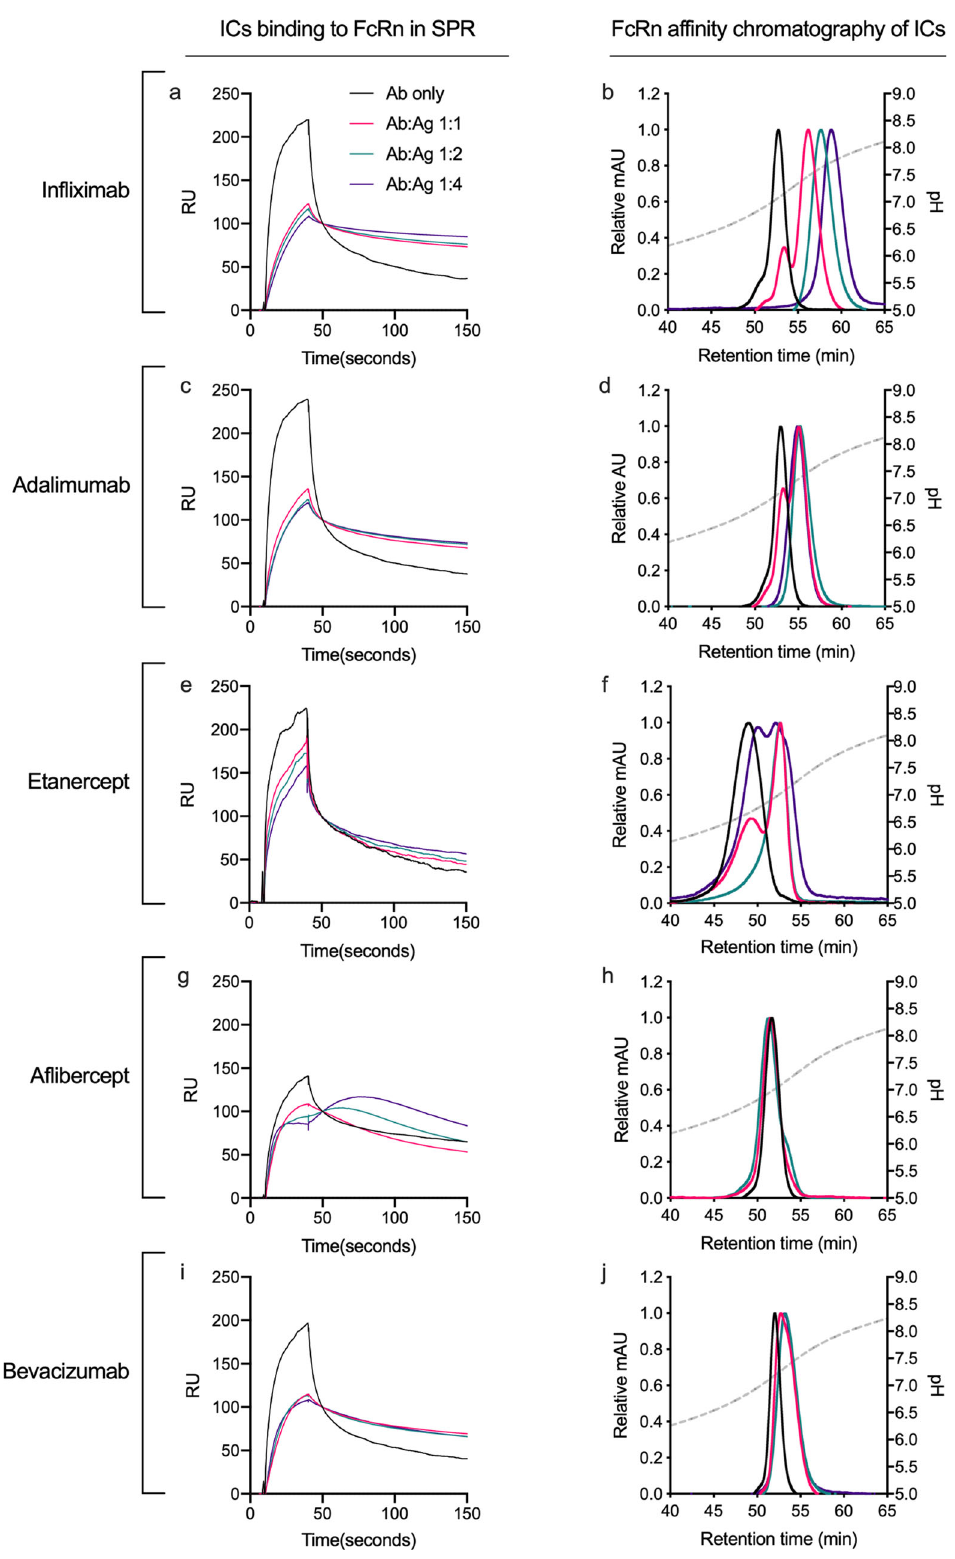
Fig. 5 Ag-binding alters the Fc-FcRn interaction. a , c , e , g , i Sensorgrams showing injection of 15.62 nM ABTs preincubated with increasing amounts of cognate Ags at pH 5.5 and injected over immobilized (~100 RU) site-speci fi cally biotinylated FcRn at pH 5.5. b , d , f , h , j Elution pro fi les from FcRn chromatography of ABTs preincubated with increasing amounts of cognate Ags at pH 5.5 shown as relative fl uorescence intensity and as a function of pH (plotted on the right Y -axis, indicated by a stapled line) Color labeling; Ab only (black), Ab:Ag 1:1 (red), Ab:Ag 1:2 (teal), Ab:Ag 1:4 (dark